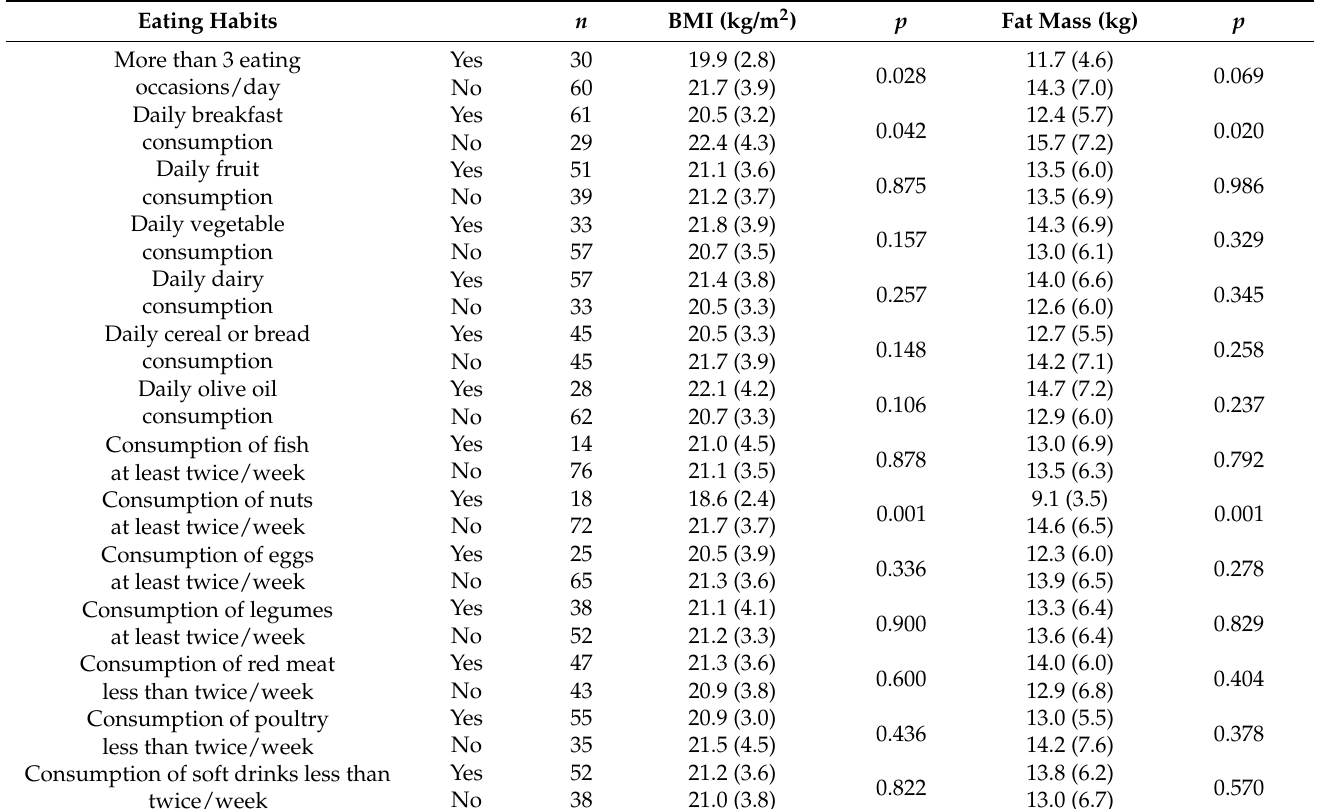
Table 3. BMI and fat mass (mean and SD) according to eating habits